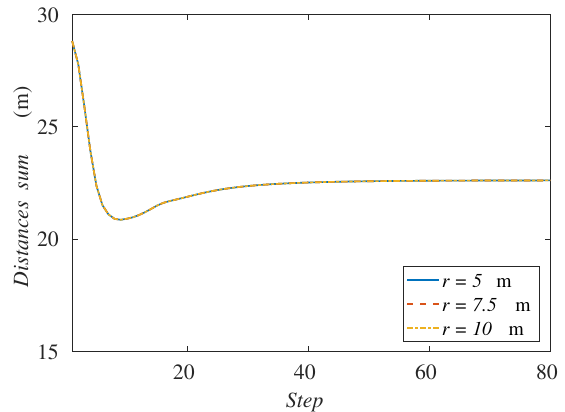
Figure 10. Sum of agents’ distances to the formation center along the simulation depending on the communication